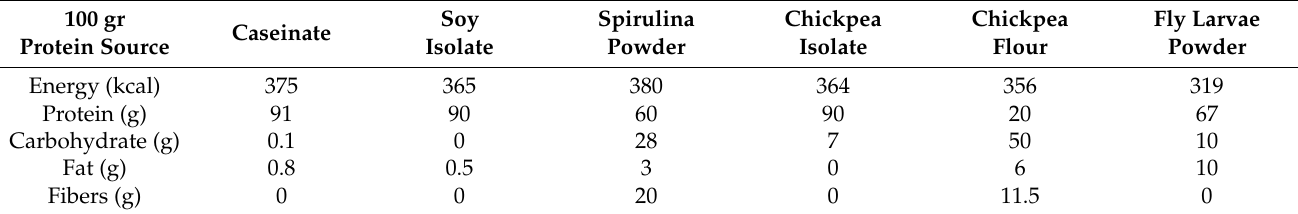
Table 2. Protein Sources Composition. Values are presented as kcal per dry weight and as grams